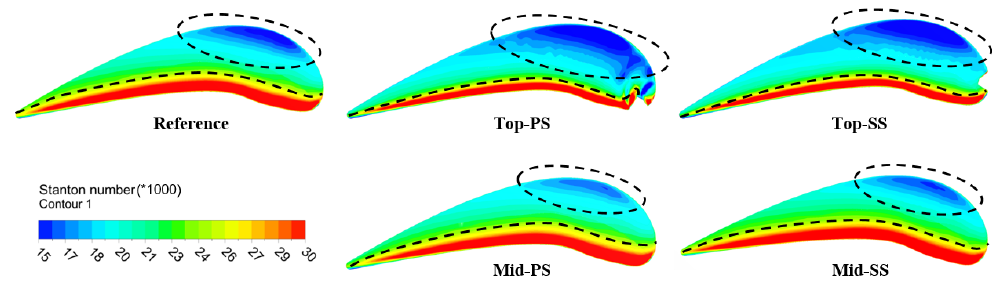
Figure 17. Stanton number distribution on blade tip under various blade conditions.